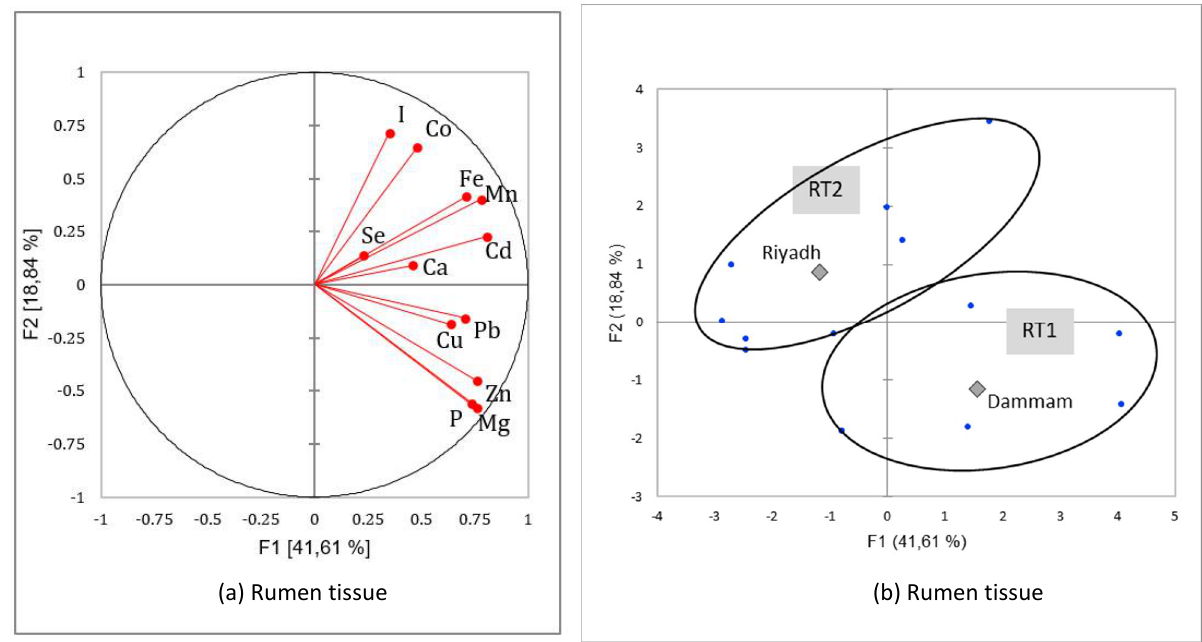
Figure 6. Correlation circles ( a ) for the two first factors of the Principal Components Analysis demonstrating the relationships between minerals in camel rumen tissue and main factorial plan ( b ) with representation of the two mineral patterns of the rumen tissue sampled in two regions of Saudi slaughterhouses at two seasons (squares represents the mean value for each region and dots the different rumen tissues sample values). Table 12. Mean values of minerals in camel rumen tissue according to the patterns issued from Ascending Hierarchical Classification [µg/g wet weight].